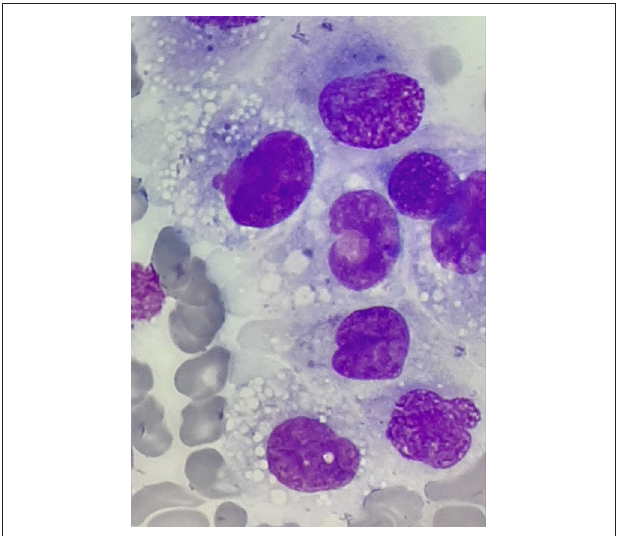
FIGURE 2 | Histiocyte proliferation in the bone marrow of patient in remission of acute lymphoblastic leukemia (ALL); magnification, × 1,000.